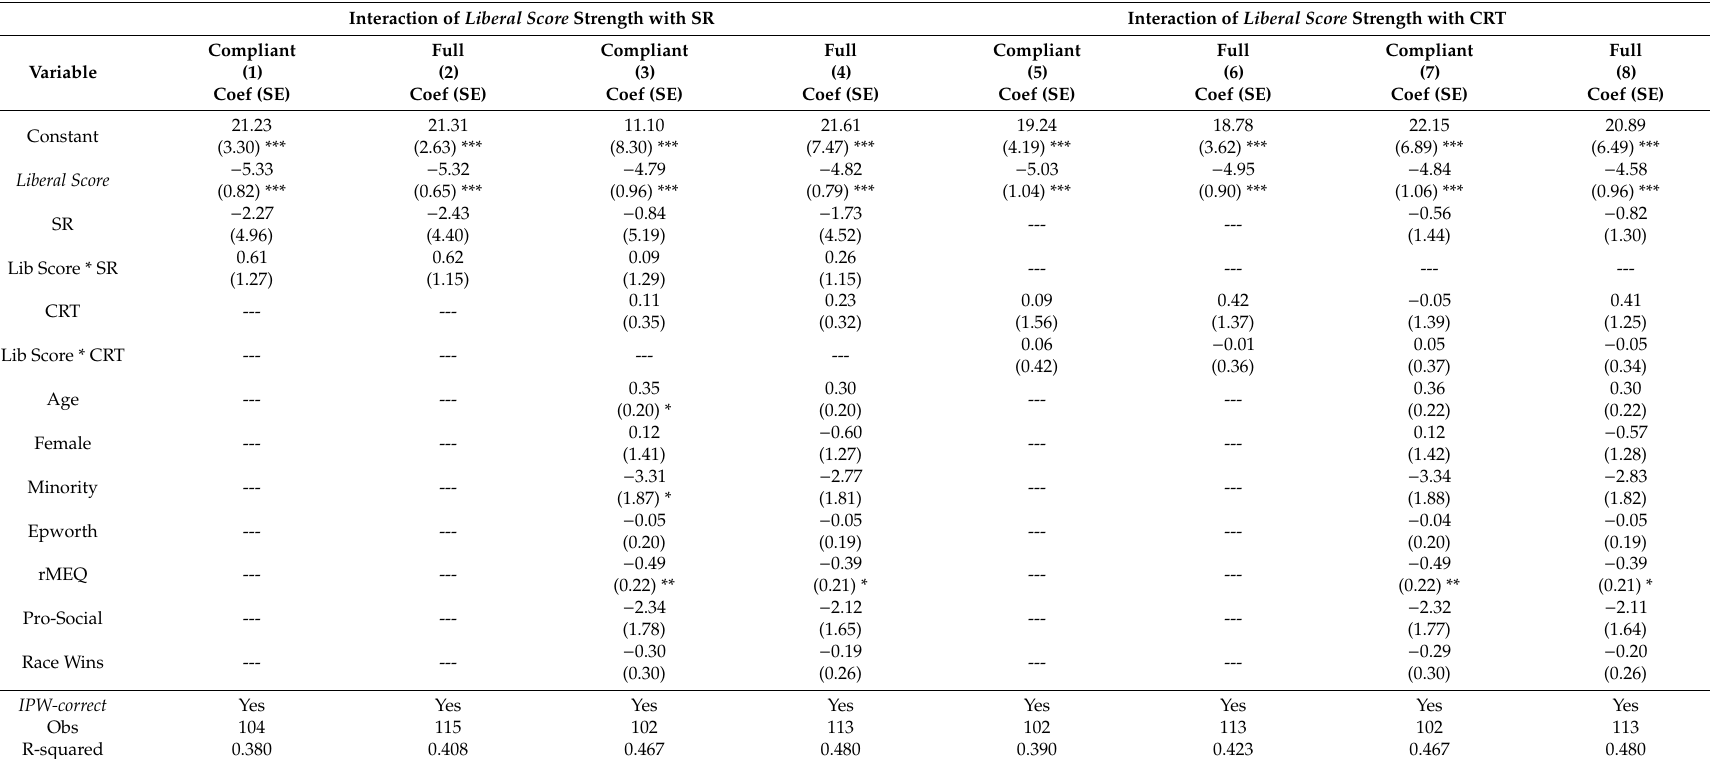
Table 7. Impact of Liberal Score and interactions on PRO-GUN-RIGHTS ARGUMENT STRENGTH. Interaction of Liberal Score Strength with